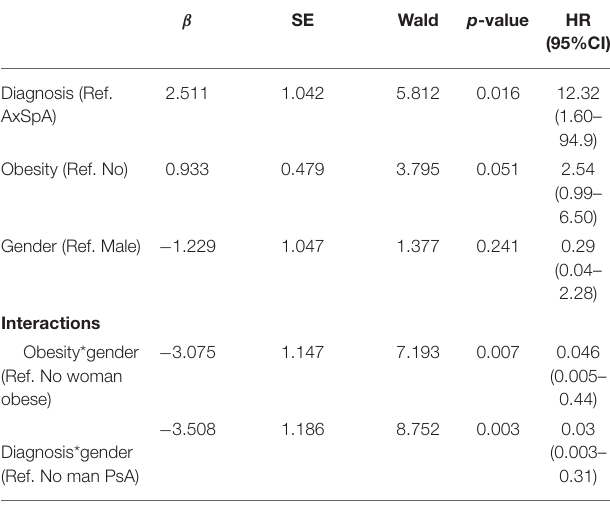
TABLE 3 | Multivariate Cox regression of discontinuation after 1 year of Secukinumab treatment in the entire population. β SE